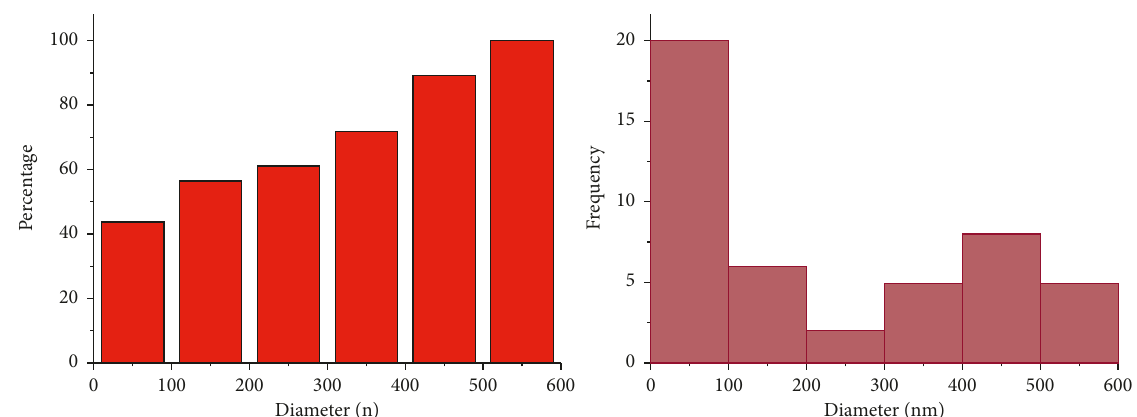
Figure 6: Histogram of synthesized ZnO/TiO